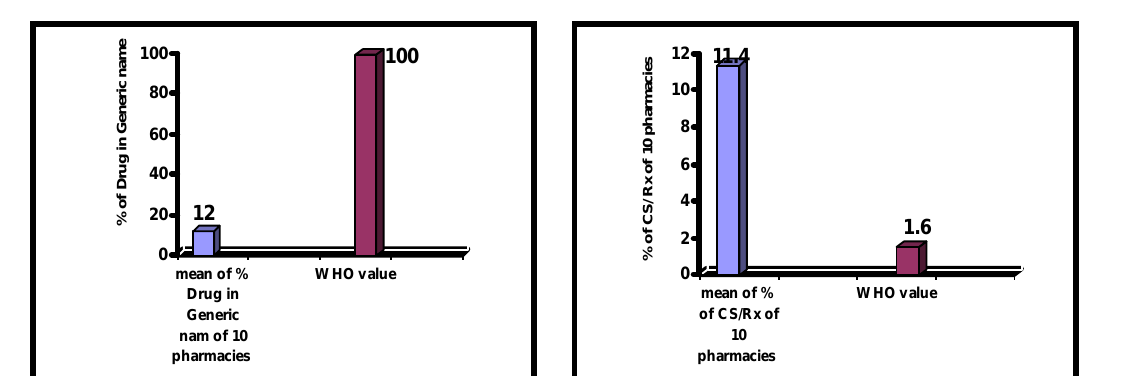
Figure 1: Comparison of the mean of average number of D/Rx in 10 pharmacies with WHO standard value.